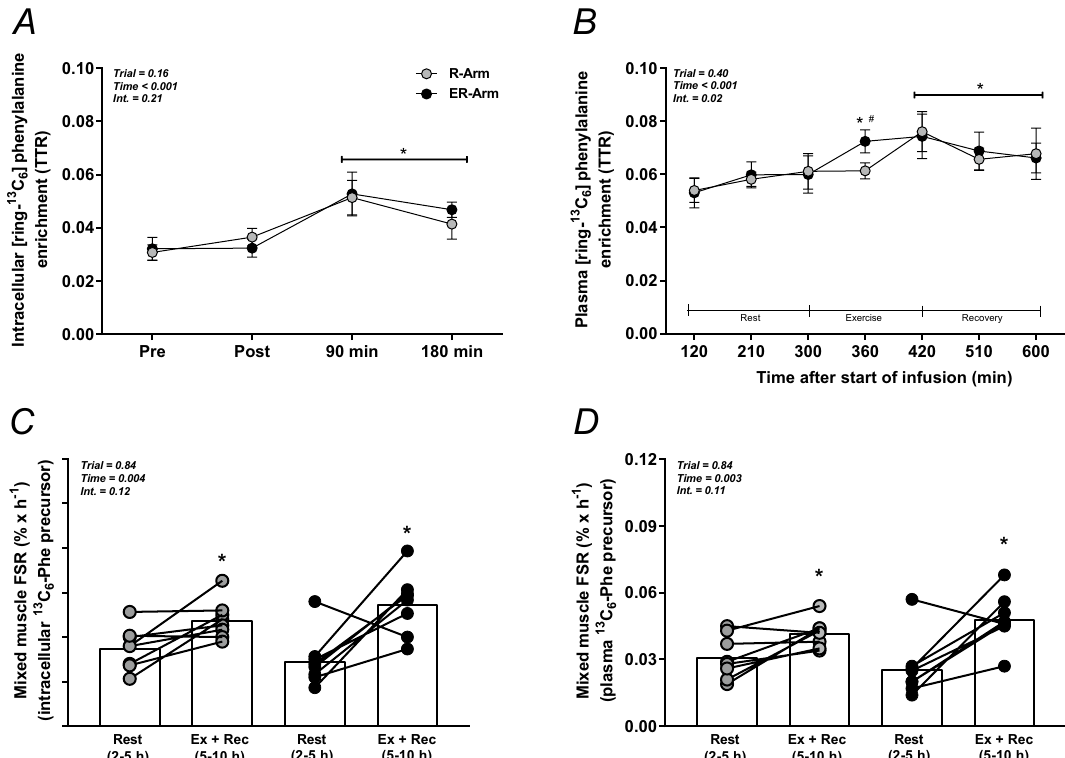
Figure 3. The FSR of mixed muscle protein based on intracellular ( A , C ) and plasma (B, D ) enrichment of L-[ring-13C6]-phenylalanine (tracer to tracee ratio: TTR) in both trials. Individual and mean values of FSR ( C , D ) over 300 min of exercise and recovery. * P < 0.05 vs. Rest, # P < 0.05 vs. the R-Arm